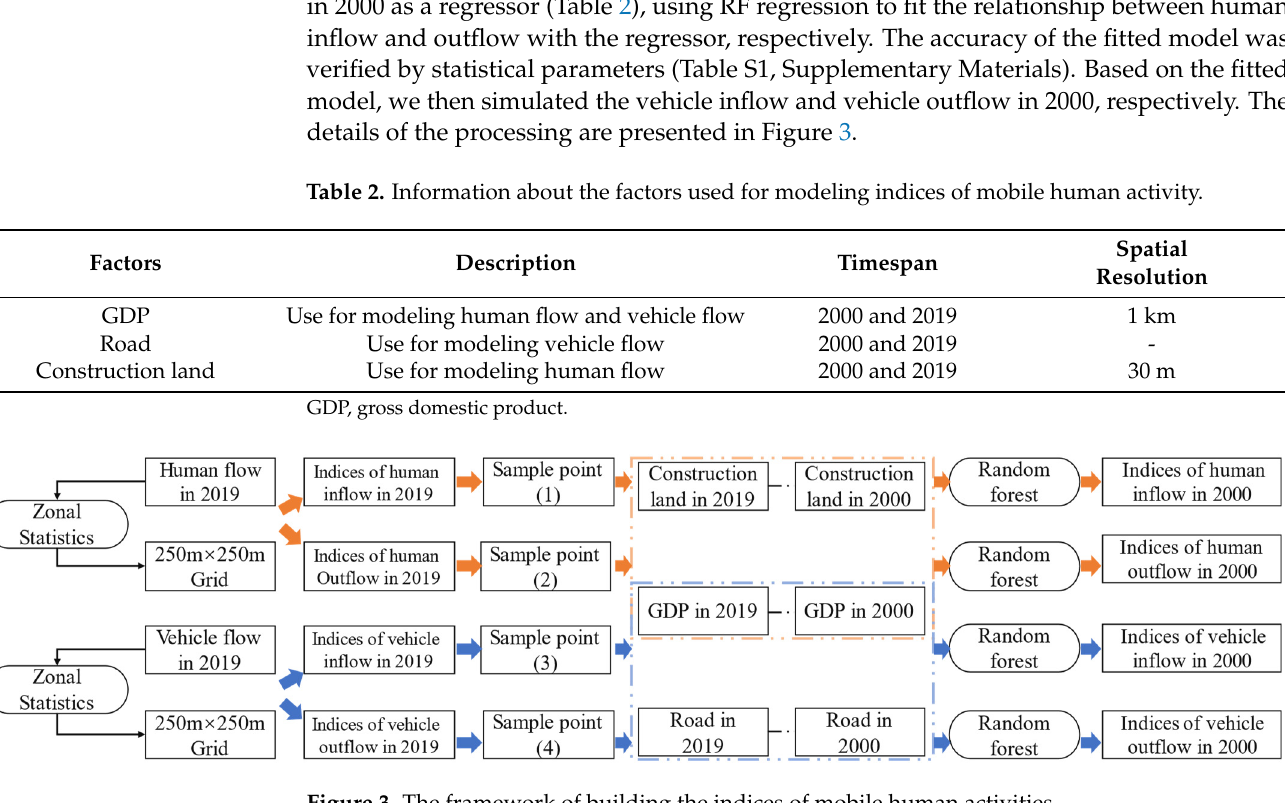
Figure 3. The framework of building the indices of mobile human activities.